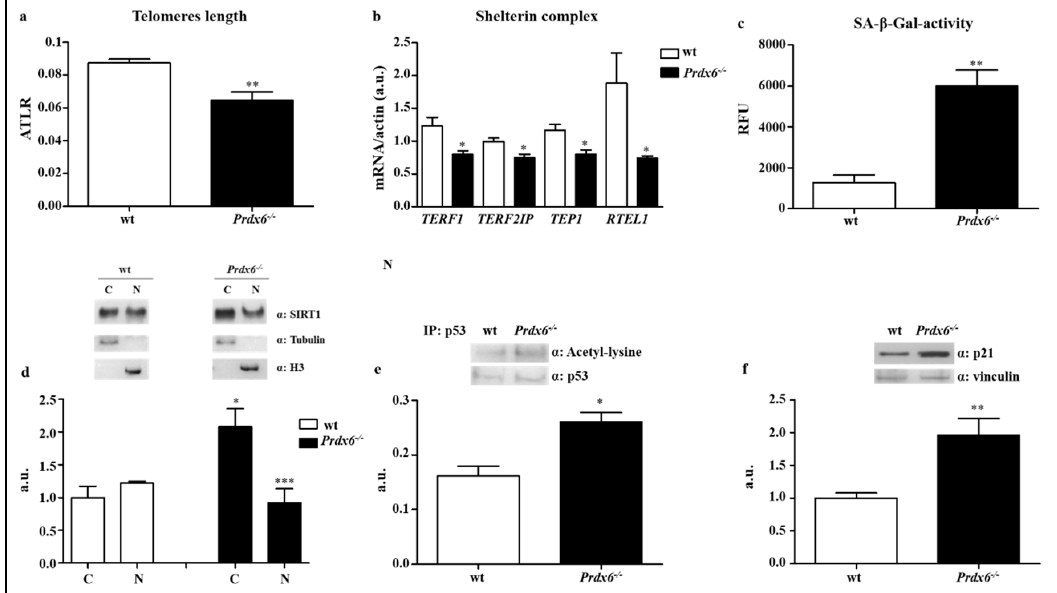
Figure 2. Prdx6 is crucial for SIRT1 nuclear translocation and p53/p21 mediated cell cycle survival. ( a ) The average telomere length ratio (ATLR) from wt (white bar) and Prdx6 -/- mice (black bar), were evaluated. ( b ) Gene expression levels of the main factors involved in telomere stabilization and elongation were analyzed in fasted (overnight) wt (white bars) and Prdx6 -/- (black bars) mice. ( c ) Senescence-associated β galactosidase activity (SA- β -gal) was assessed. ( d ) SIRT1 nuclear and cytoplasmic localization was quantified following cellular fractionation. * p < 0.05 Prdx6 -/- vs. wt cytoplasm; *** p < 0.0005 Prdx6 -/- vs. wt nucleus. ( e ) Immunoprecipitation assay for p53 was performed on gastrocnemius muscle of both mouse models. ( f ) p21 levels were enhanced in Prdx6 -/- than wt mice. Data are reported as mean ± SE. * p < 0.05, ** p < 0.005 using Student t test. Graphs illustrate one of three separate studies, all yielding similar results ( n = 5 mice per group). RFU = relative fluorescence unit; a.u., arbitrary units; C = cytoplasm; N = nucleus.